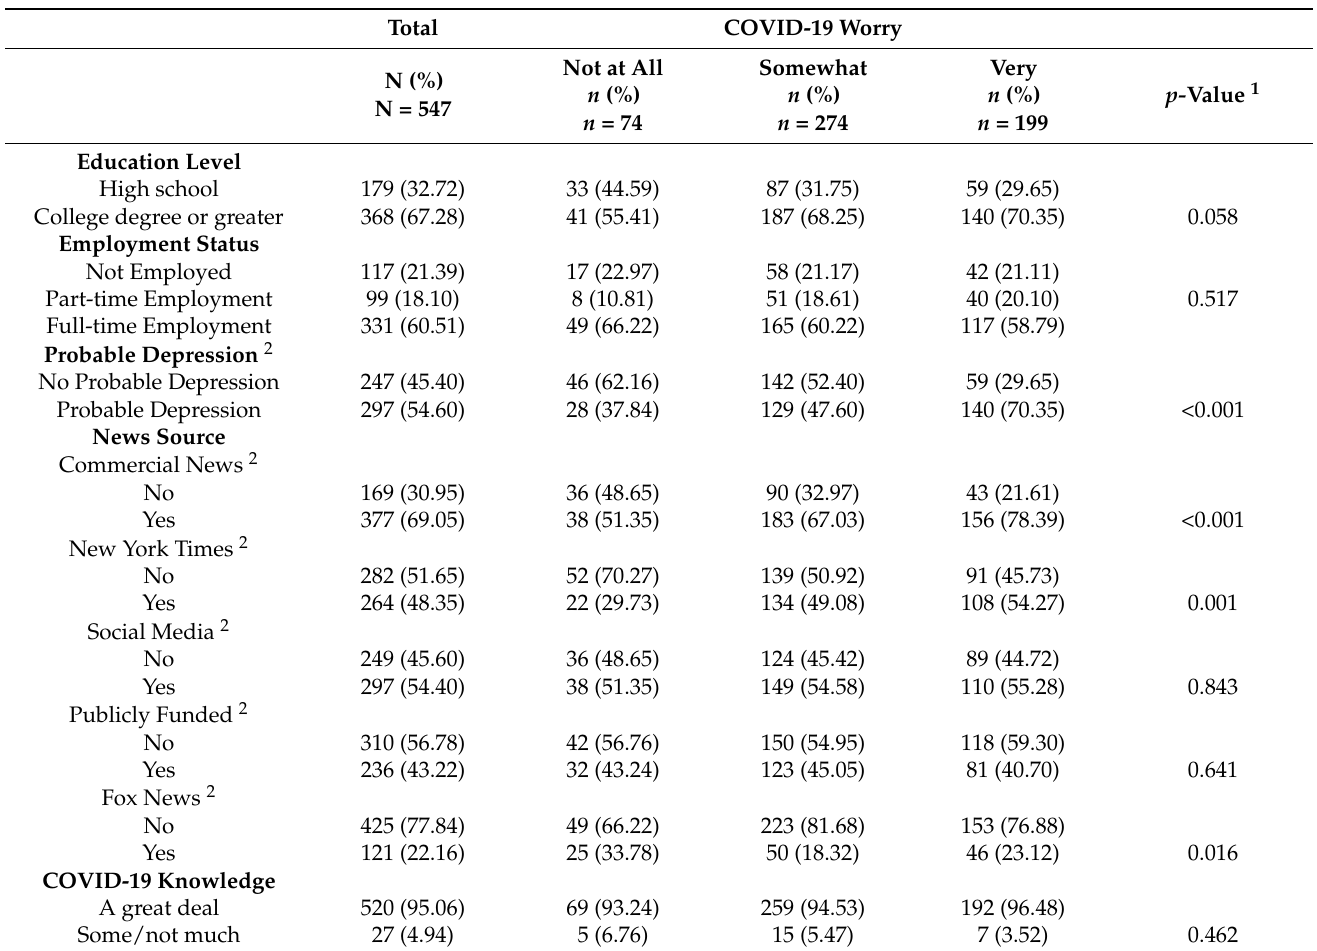
Table 2 shows the results of univariate and bivariate analyses for the national sample. Unlike the New York State sample, most respondents were male (63.9%) and over half were under the age of 34. Although the majority identified as Non-Hispanic White (57.1%), greater proportions identified as Hispanic (26.4%) and Non-Hispanic Black (13.5%), while only 3% identified as Asian. Larger majorities of the national sample had a college degree or greater (74.8%), full-time employment (79.8%), and probable depression (65.7%). Other marked differences include that in the national sample, the majority (65.7%) of respondents endorsed COVID-19 stigma and a greater proportion had ‘some’ or ‘not much’ knowledge of COVID-19 (16.9%). The consumption of news sources also differed slightly, with